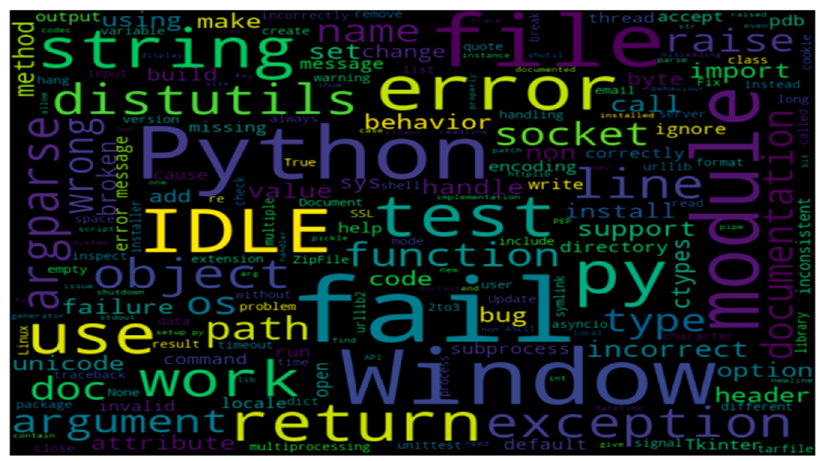
Figure 4. Word Cloud of “Performance error”.